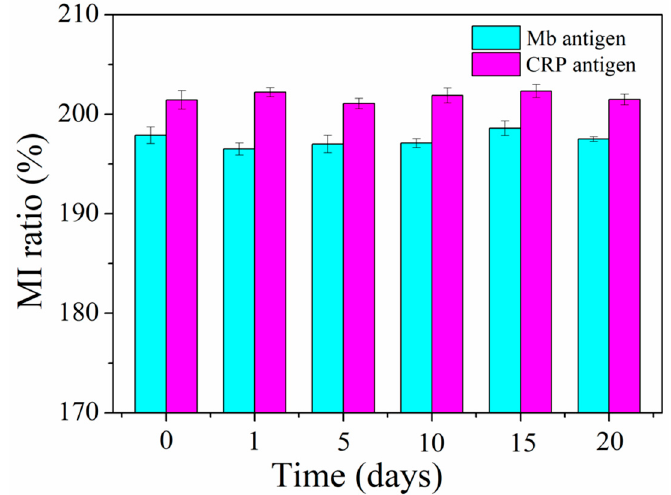
Figure 6. Stability test of the MI-based bio-analytic system in 0.1 pg/mL Mb and 100 ng/mL CRP.